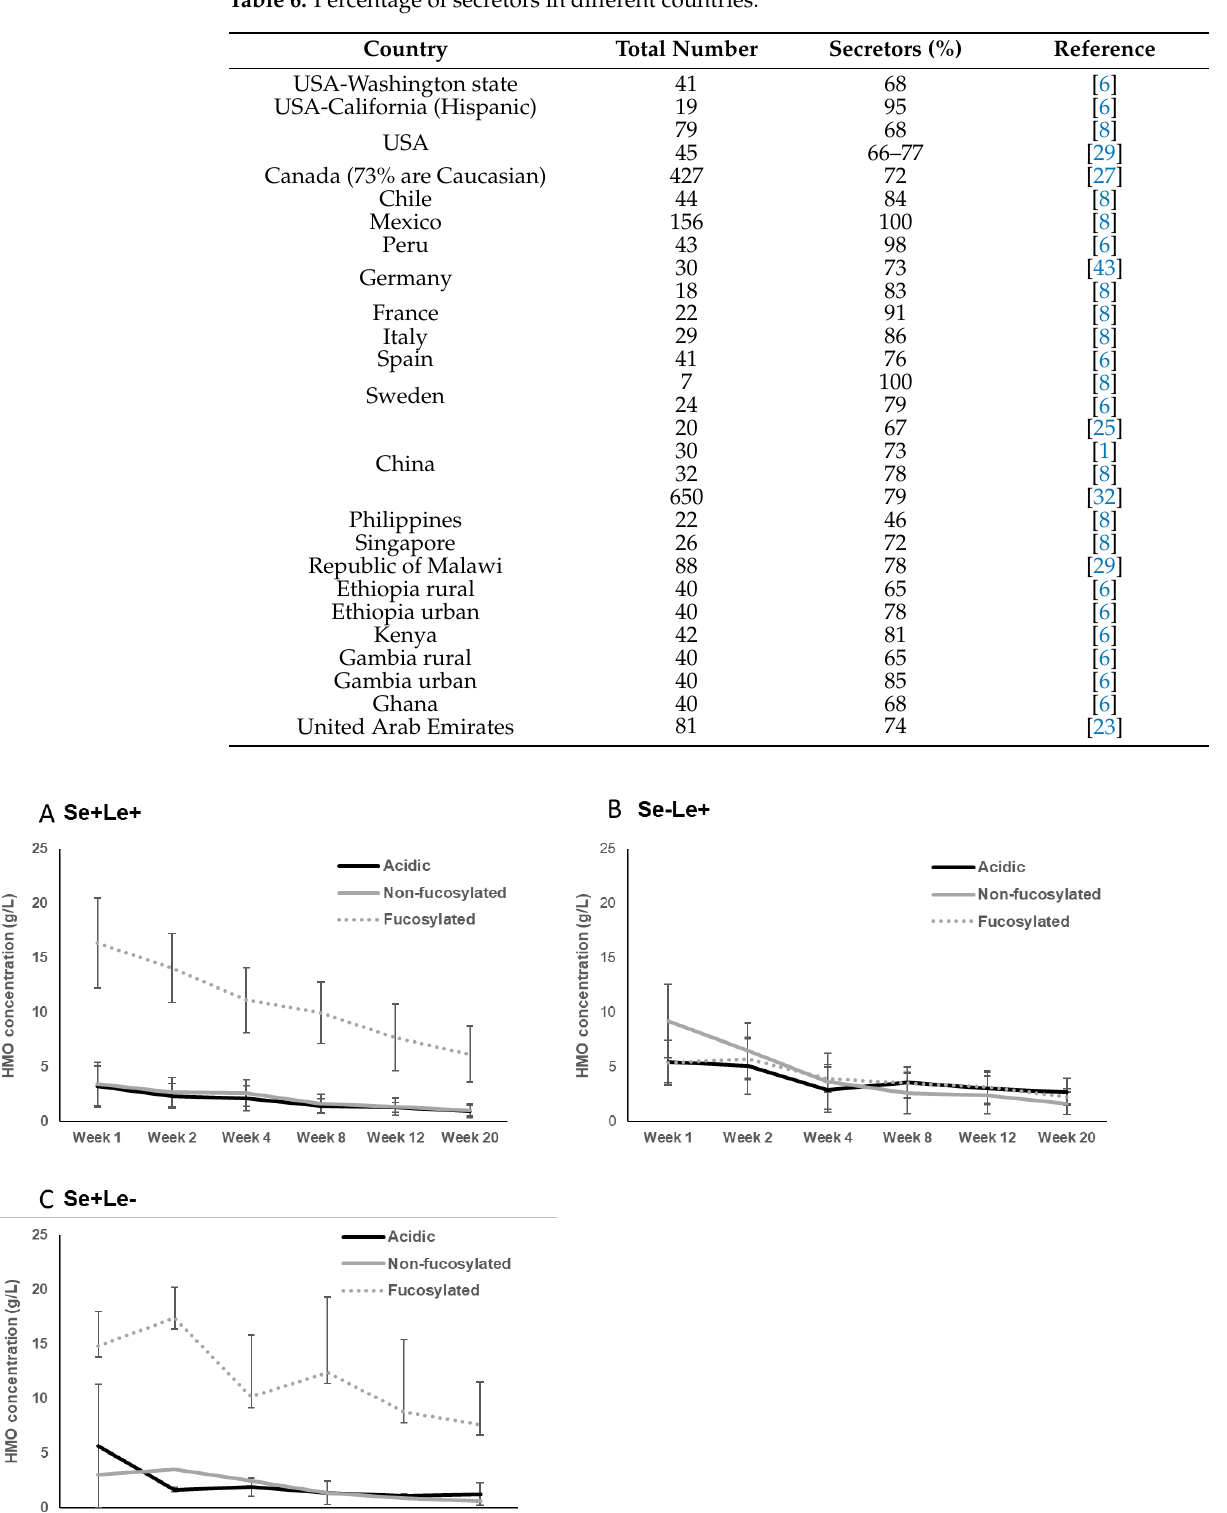
Table 6. Percentage of secretors in different countries.